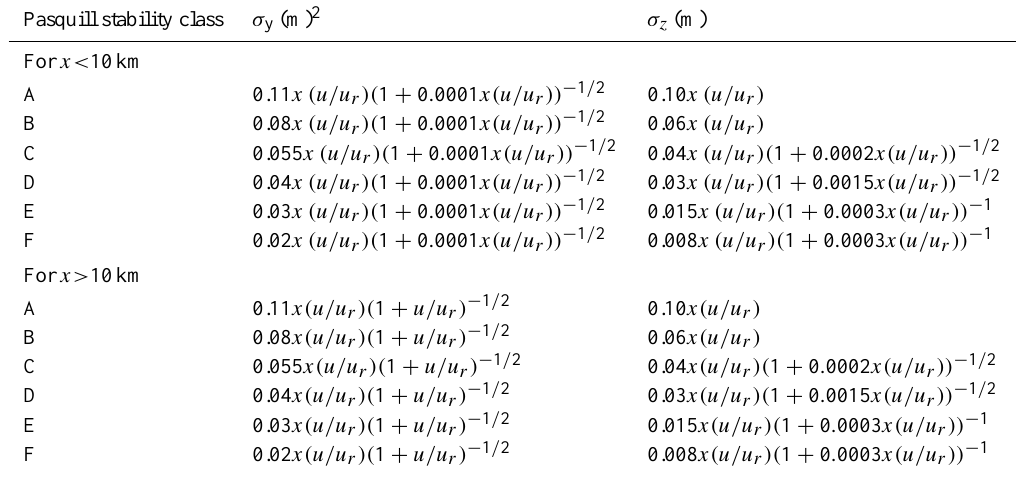
Table 1. Formulas for the later and vertical dispersion parameters, σ y (x) and σ z (x) , as a function of the downwind distance, x (m), over the ocean 1 .